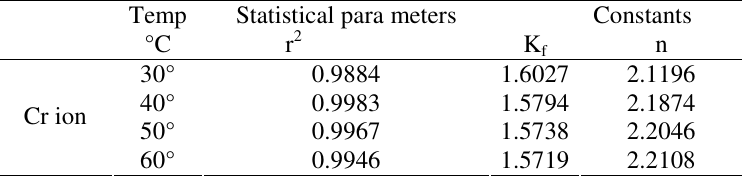
Table 5. Freundlich isotherm Results Temp Statistical para meters